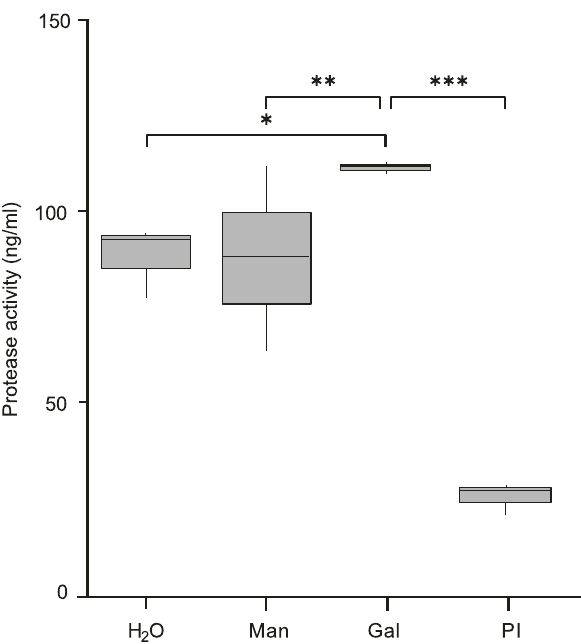
Fig. 3 Protease activity detected in supernatants of B. salamandrivorans zoospores. Supernatants were collected by centrifuging the B . salamandrivorans zoospore suspensions treated with 50 mM D-galactose (Gal), 50 mM D-mannose (Man), H 2 O and protease inhibitor mix (PI). Three technical replicates were performed per biological replicate, with three biological replicates in total. In the box-and-whisker plots, the median is shown as a line inside the box, the fi rst and third quartiles shown as the lower and upper edges of the box, respectively, and the minimum and maximum values shown as whiskers. The signi fi cance of difference between the means is shown by * p = 0.036, ** p = 0.008, *** p < 0.001; based on Tukey ’ s multiple comparisons test comparing two-sided linear mixed models. Source data are provided as a Source Data fi